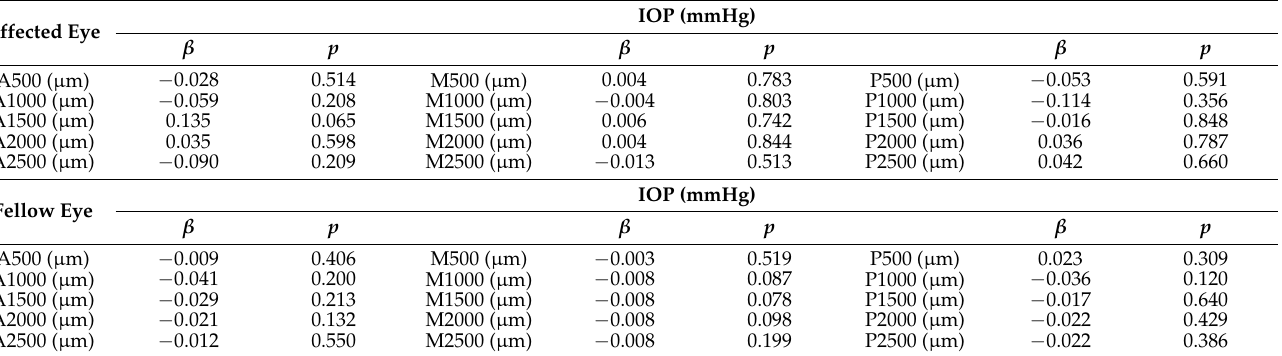
Table 5. Univariate linear regression of associations of iris thickness and IOP in PSS-affected and fellow